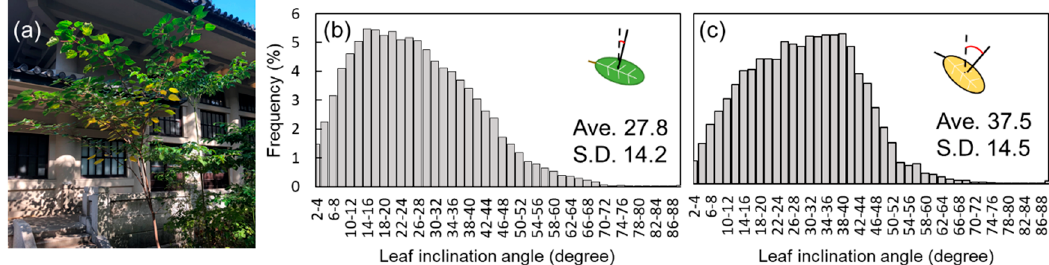
Figure 8. Distribution of leaf inclination angle within a tree (Japanese Mallotus). Panel ( a ) shows original image. Panels ( b ) and ( c ) show distributions in green part and non-green part, respectively. Criterion of classification is normalized G value of 0.4.